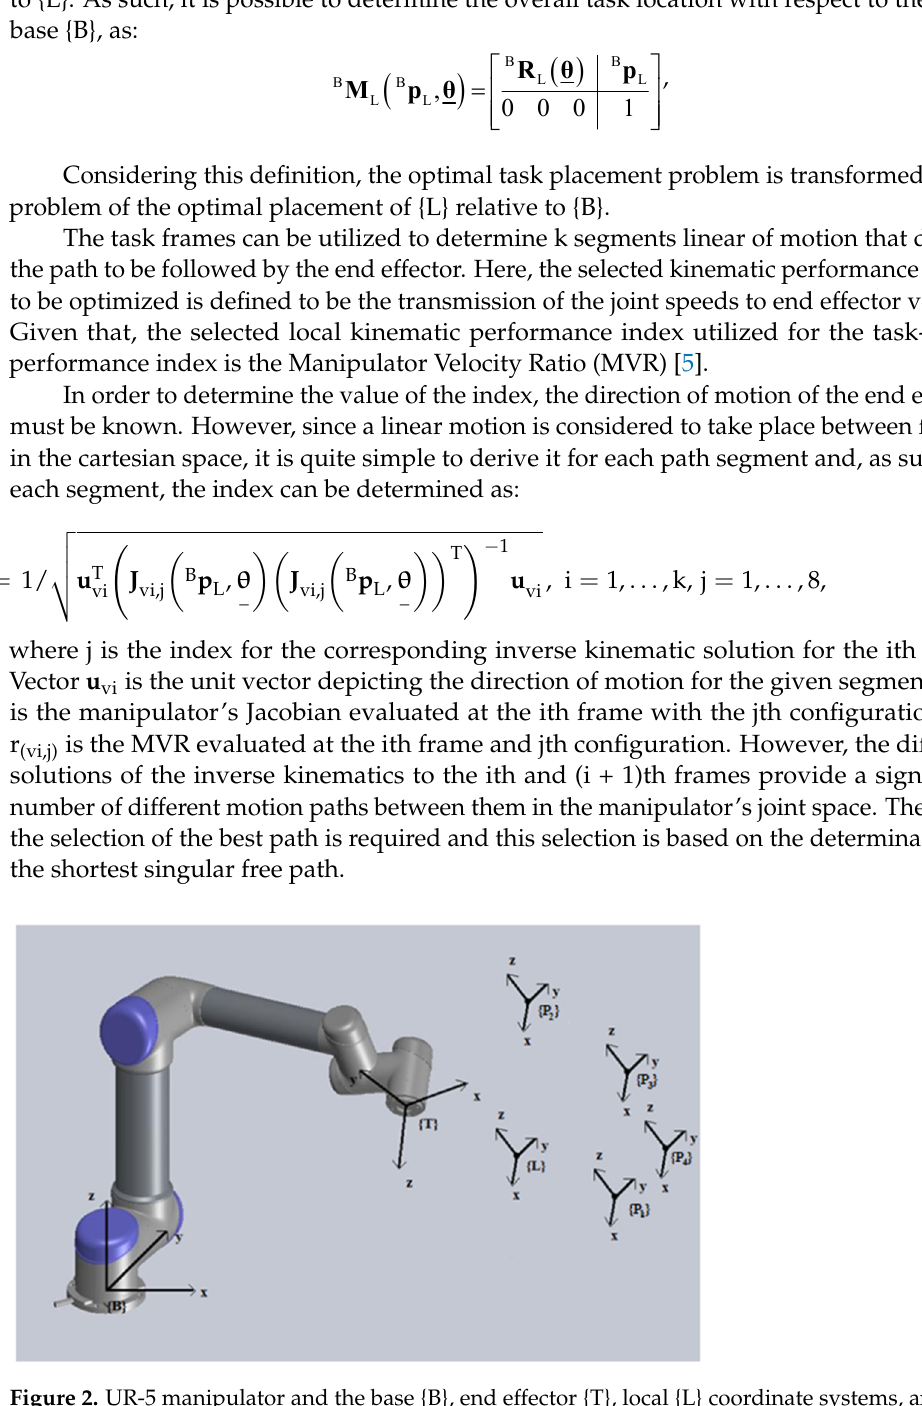
Figure 2. UR-5 manipulator and the base {B}, end effector {T}, local {L} coordinate systems, and task frames {P i }.